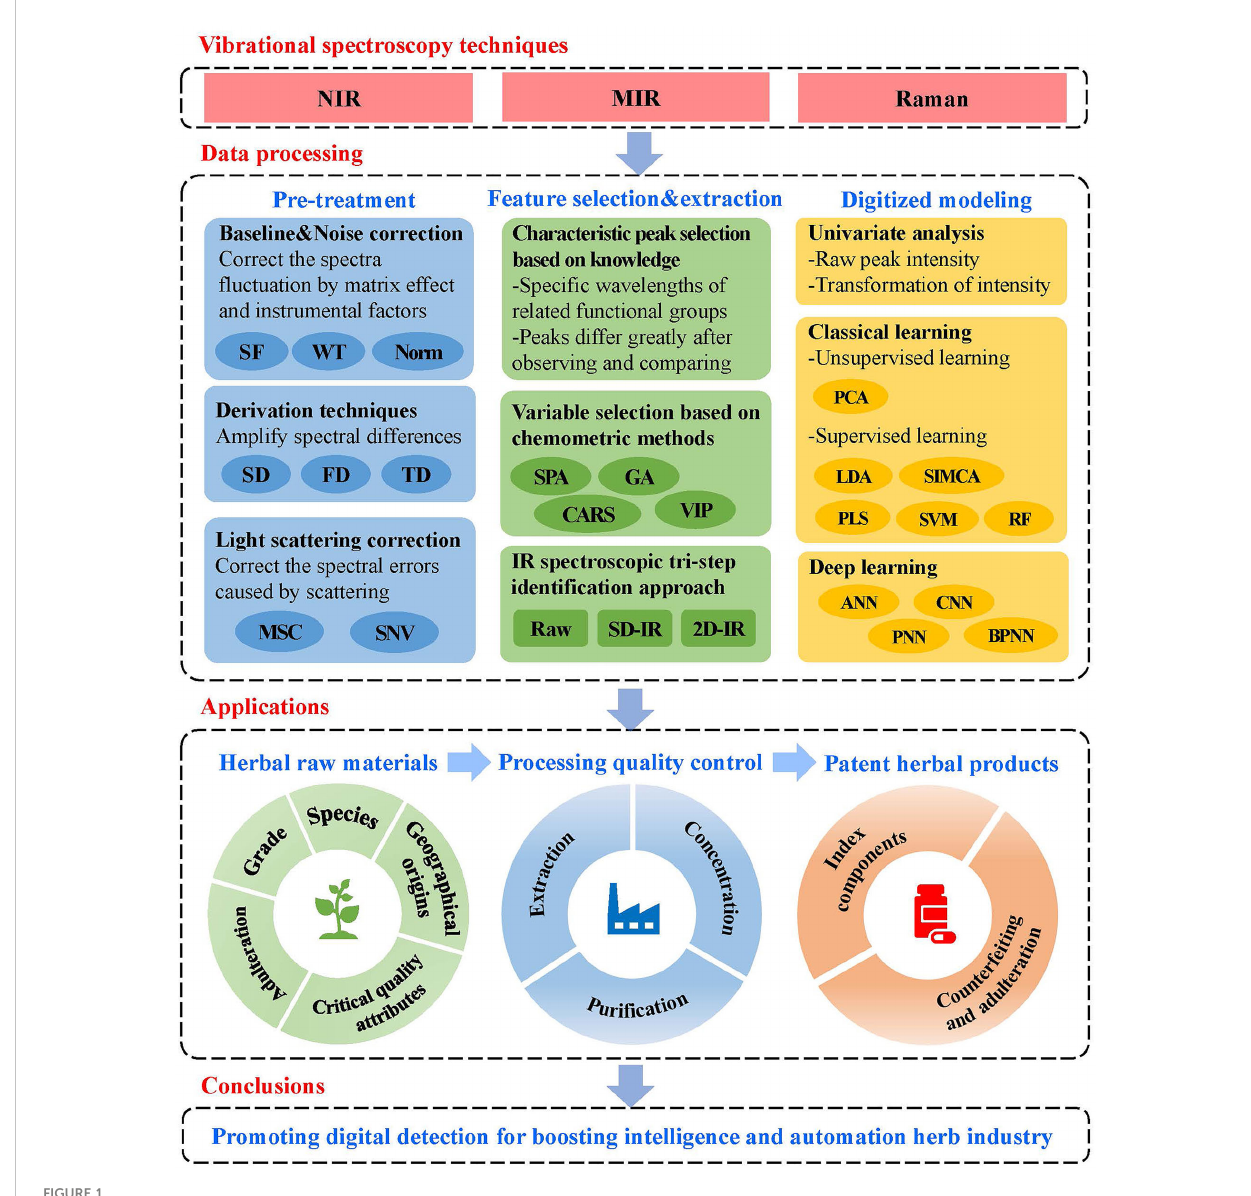
FIGURE 1 The framework of the